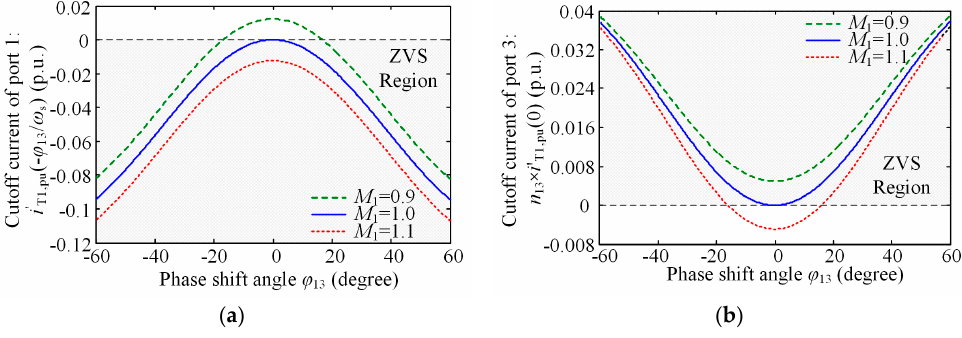
Figure 7. ZVS realization regions of port 1 and port 3 under varying M 1 : ( a ) port 1; ( b ) port 3.